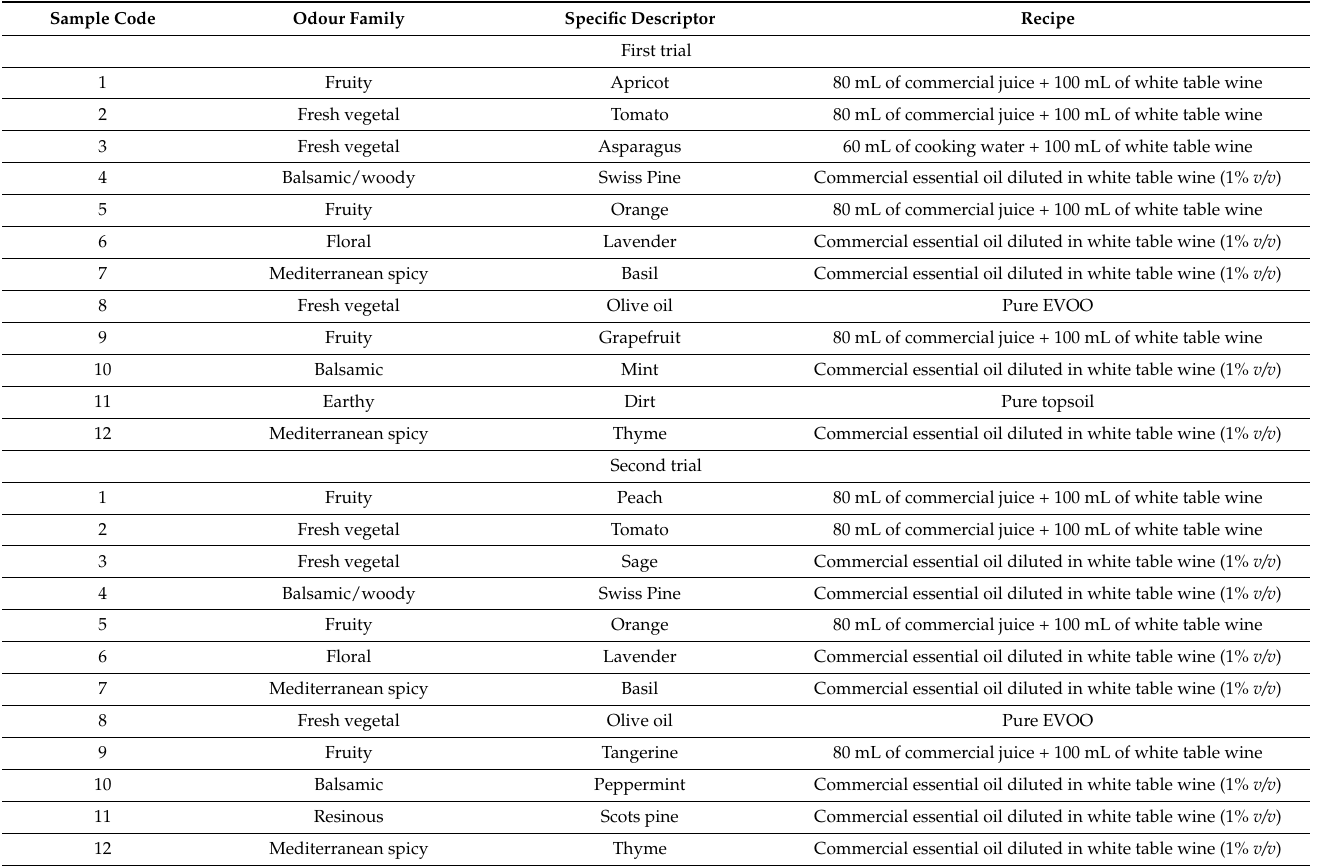
Table 1. Odorous solutions used for the stimulation. Solutions were stored for 24 h in the dark at room temperature (20 ± 1 ◦